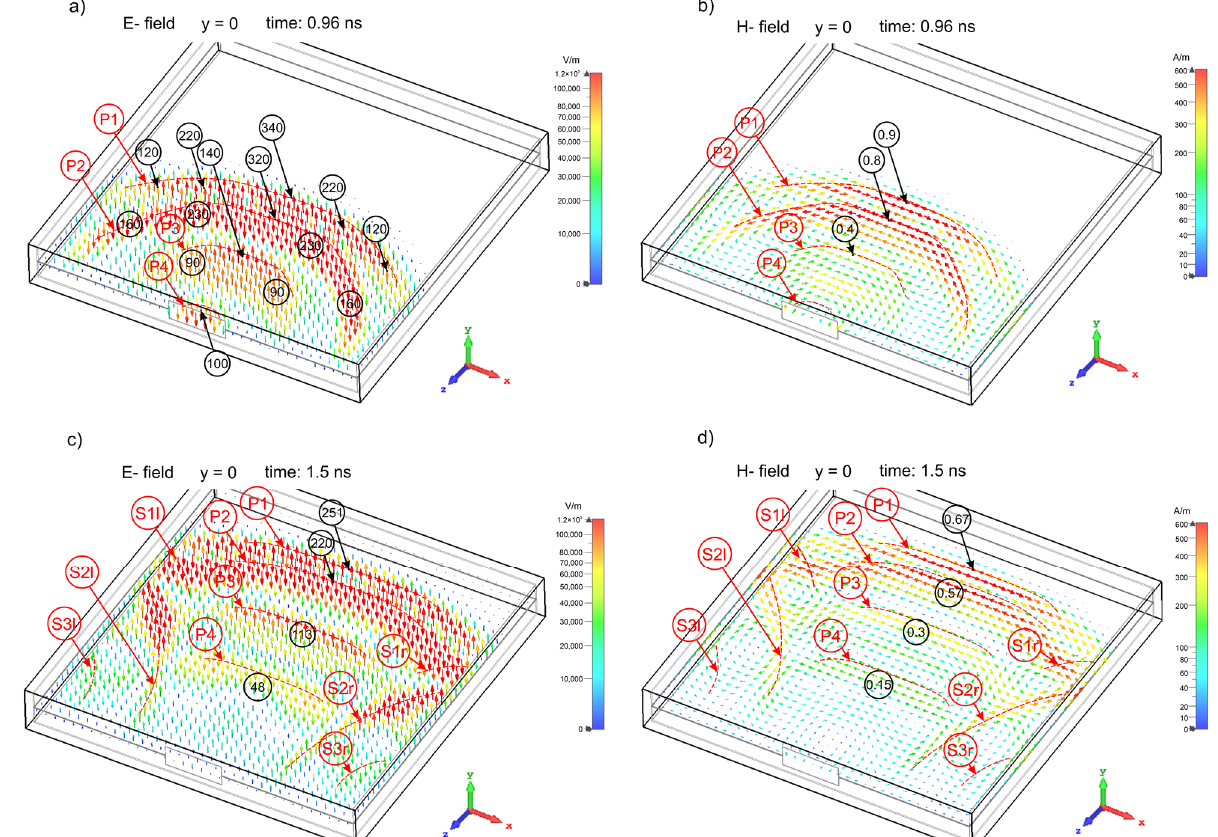
Figure 4. 2D vector maps illustrating development of the electric and magnetic fields in the wave phase in the enclosure for various times. Left column —the electric field amplitude, right column — the magnetic field amplitude. The amplitudes of the electric field at 10 3 V/m and magnetic field at 10 3 A/m are given in circles. P1, P2, P3, and P4—the primary waves, S1l, S2l, and S3l—the secondary waves formed at the left side of the enclosure; S1r, S2r and S3r—the secondary waves formed at the right side of the enclosure. ( a , b ) and ( c , d ) show the electric and magnetic fields at times t = 0.96 ns and t = 1.5 ns, respectively.